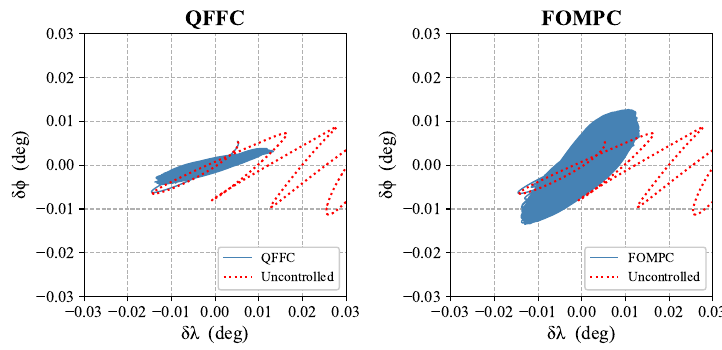
Figure 4. The comparison of the trajectories in the ( δλ , δφ )